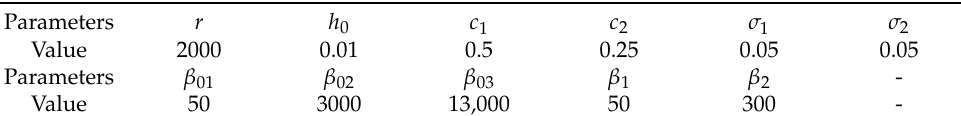
Table 3. Simulation of ADRC parameters under sinusoidal signal.